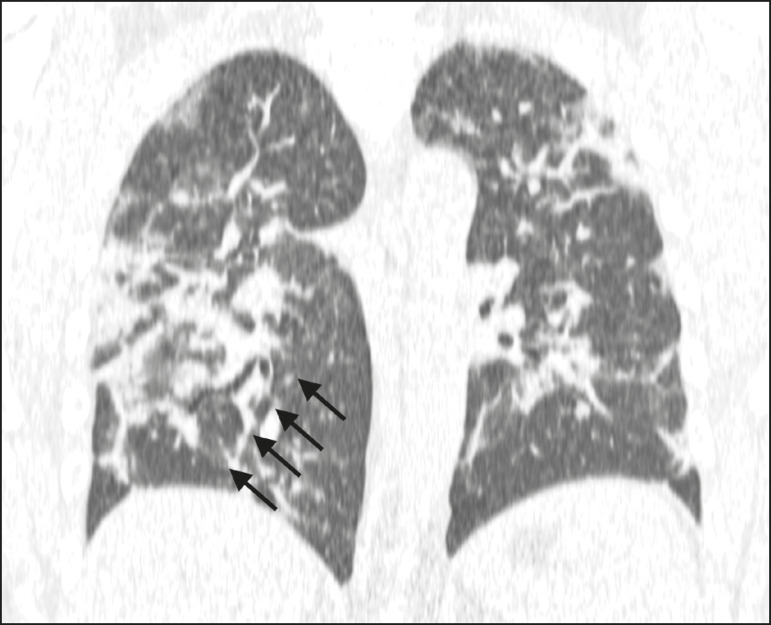
A 36-year-old male patient at 15 days after symptom onset. Chest CT scan showing areas of consolidation together with bronchial ectasia (arrows).